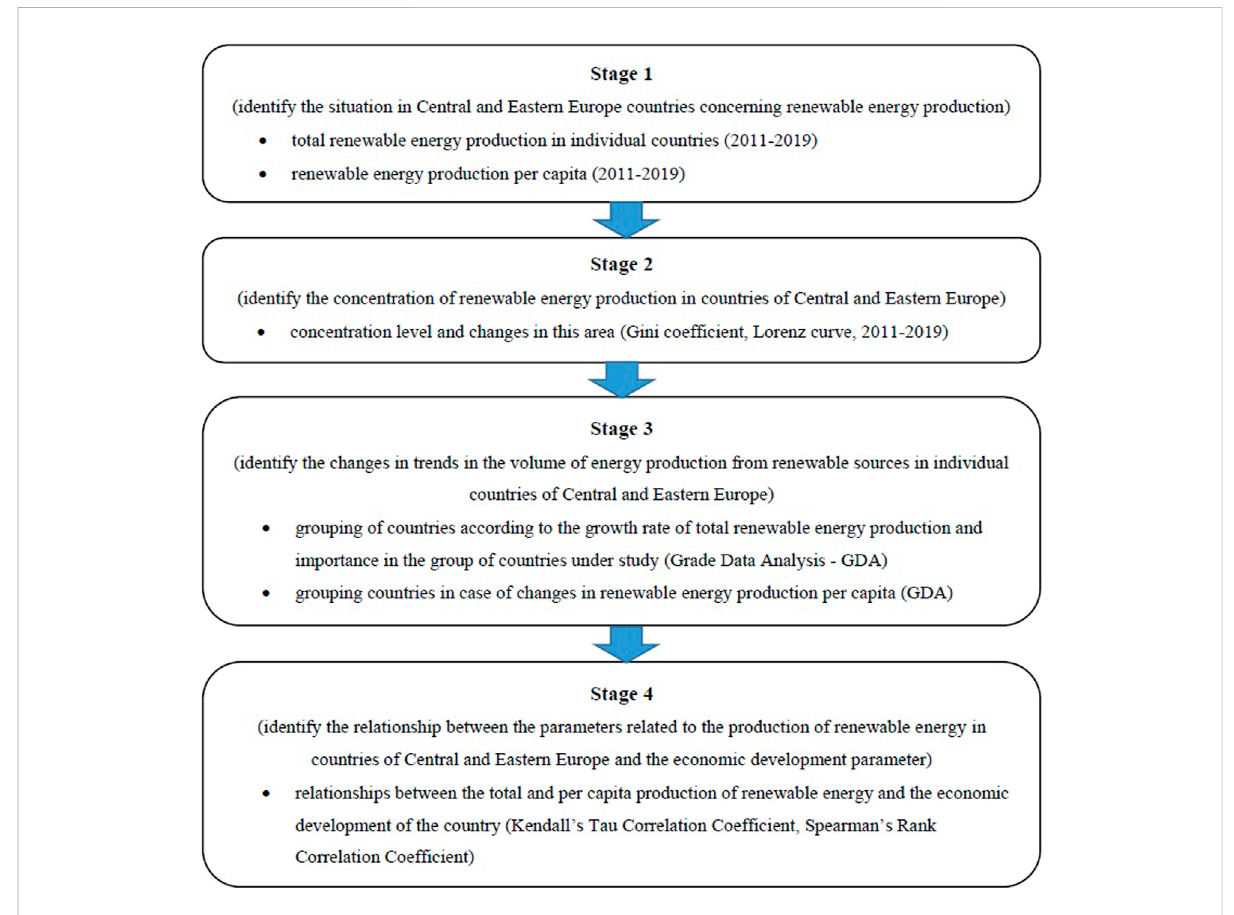
FIGURE 1 The framework scheme of the